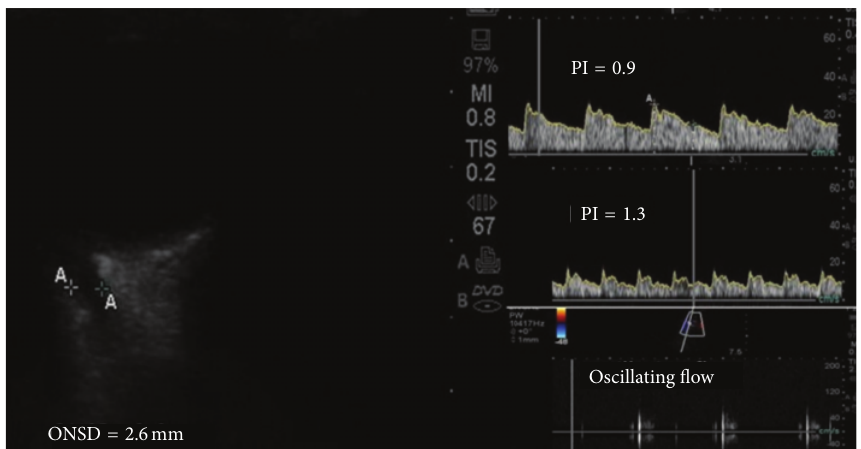
Figure 4: (Left panel) Ultrasound measurements (volume of autologous blood volume infusion = 0.8mL) by means of the “dark stripe” method depicting an increased ONSD of 2.6 mm in a rabbit with increased ICP (30mmHg). (Right panel) TCCD waveforms depicting sequentially: a normal PI (top, volume of autologous blood infusion = 0.1 mL, ICP = 7mmHg), an increased PI of 1.3 (middle, volume of autologous blood infusion = 0.6 mL, ICP = 21mmHg, and oscillating flow soon after the occurrence of the Cushing reaction (bottom, volume of autologous blood infusion = 1mL, ICP =40mm Hg).